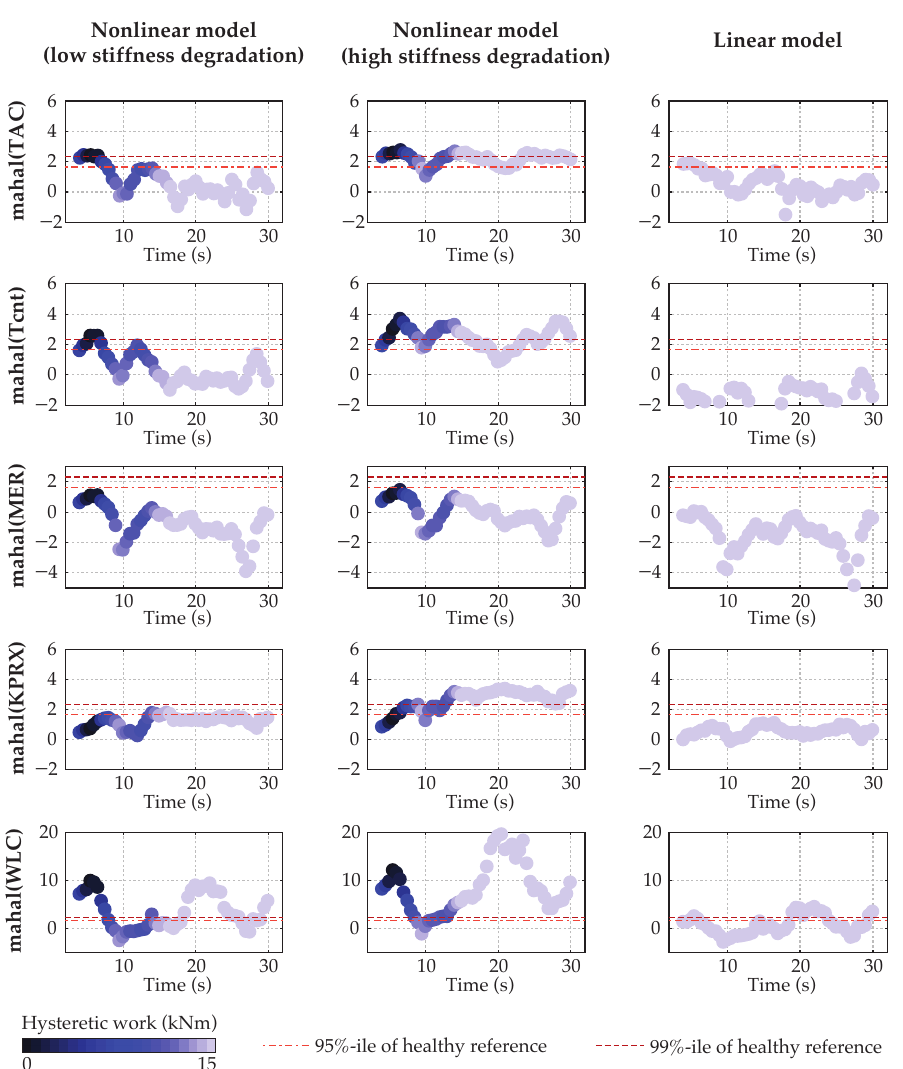
Figure 13. DSFs evaluated on short time windows for a nonlinear response with low stiffness degradation ( left ), high stiffness degradation ( center ), and a linear response ( right ) to the Montenegro earthquake. Tracking the DSFs over time allows us to separate peak and residual